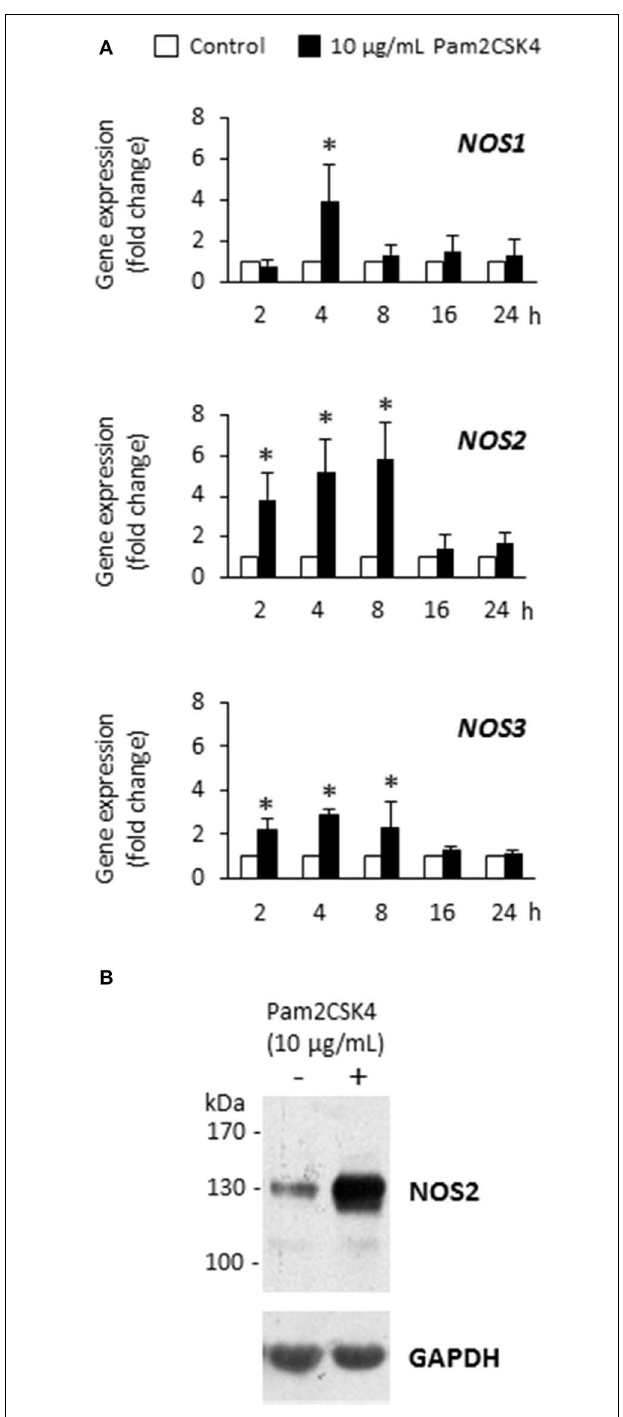
FIGURE 1 | Pam2CSK4 increases NOS1 , NOS2, and NOS3 gene expression and NOS2 protein synthesis in odontoblast-like cells. (A) Analysis of NOS1 , NOS2, and NOS3 gene expression after cell challenge with 10 µ g/mL Pam2CSK4 for the indicated times. The three genes were significantly up-regulated upon Pam2CSK4 stimulation, NOS2 being the most up-regulated one ( n = 4 ). * p < 0 . 05 . (B) At the protein level, NOS2 synthesis was clearly increased after 8h of odontoblast-like cell stimulation with 10 µ g/mL Pam2CSK4. The gel shown is representative of three independent experiments.